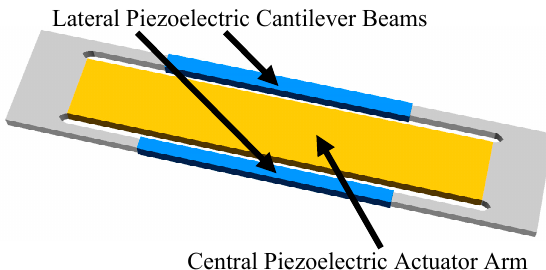
Figure 13. Schematic representation of the piezoelectric actuators based MTT proposed in [25,26].